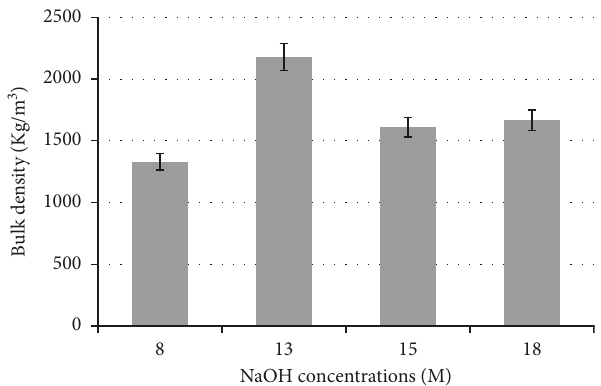
Figure 4: Compressive strengths of hardened geopolymer cement prepared with various NaOH concentrations.